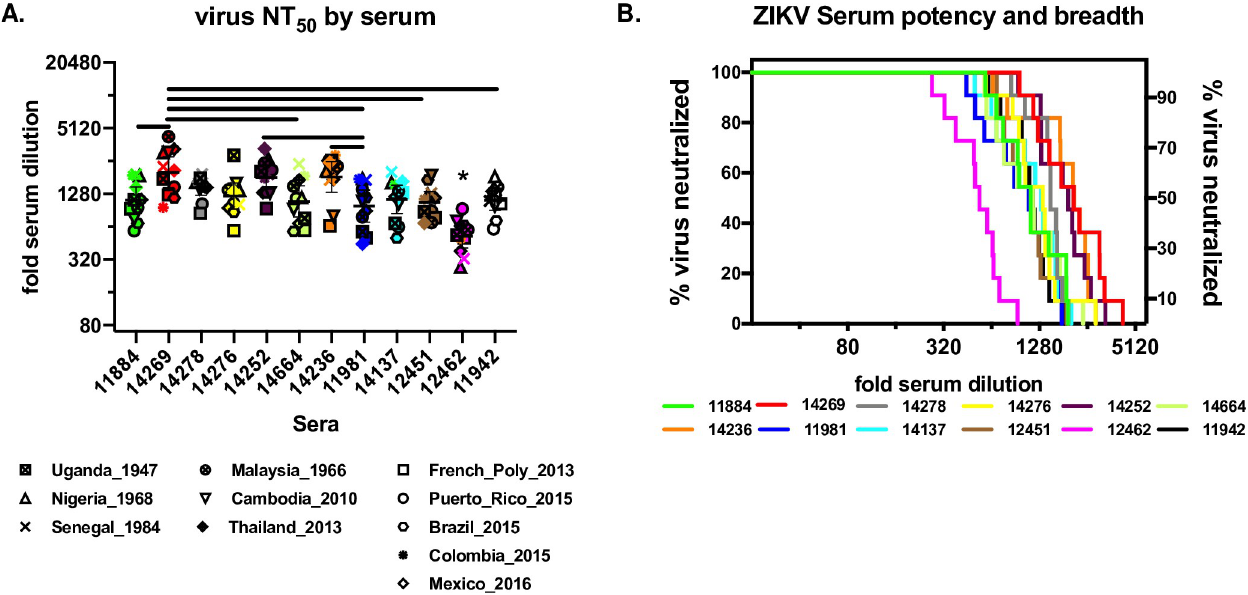
Fig 3. Potency and breadth of subject immune sera. A) GMT for each serum against eleven ZIKV isolates. Y-axis shows fold-serum dilution, each virus FNRT 50 value is plotted by the correlating symbol show in the legend below the plot. The symbols are color coded to match the sera indicated in Fig 2. Line and whiskers show serum GMT and 95% confidence. The GMT for subject 12462 ( � ) was significantly lower than all other sera (ANOVA followed by Tukey’s correction for multiple comparisons, P < 0.05). Remaining sera pairs that had GMTs that differed significantly are show by horizontal bars (ANOVA followed by Tukey’s correction for multiple comparisons, P < 0.05) B) Potency and breadth curve for each subject serum. The Y-axes shows proportion of viruses neutralized (N = 11), X axis shows fold serum dilution. The plots are color coded to match the sera in Fig 2. The plot for each serum shows the proportion of viruses neutralized by FRNT 50 at a given serum dilution. Each step in each plot represents an FRNT 50 value for one virus; as fold serum dilution increases for each serum, the proportion of viruses neutralized decreases by 1/11 (9.1%) as each FRNT 50 dilution for each virus is crossed. � differs from 12462, Mantel-Cox followed by Bonferroni’s correction for multiple comparisons, P <